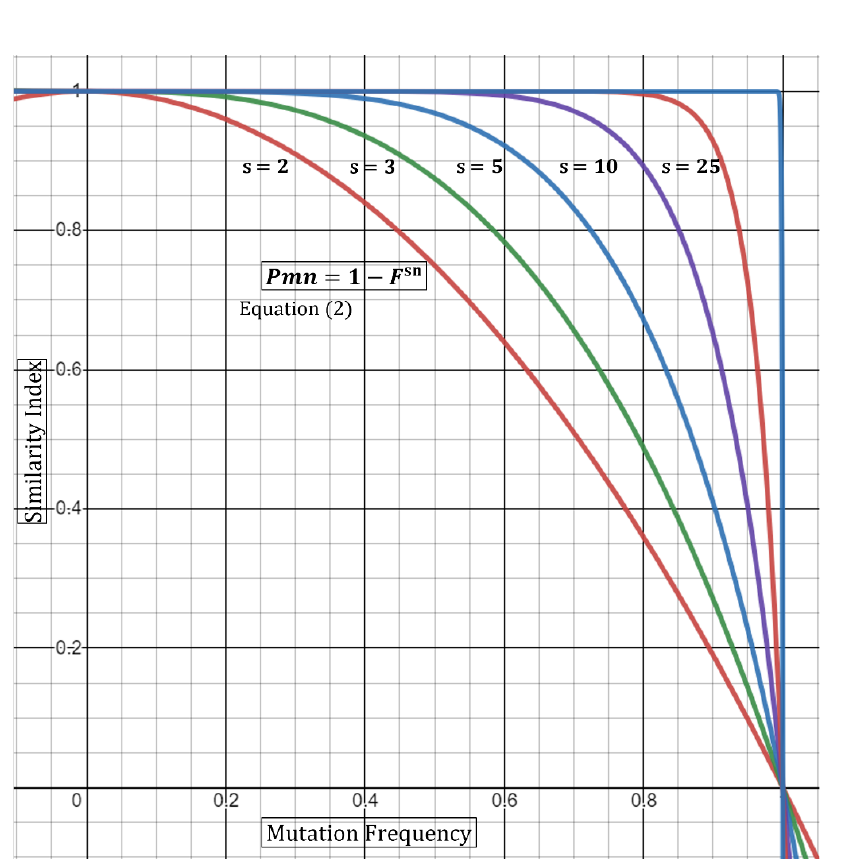
Figure 1. Graphical representation of Equation (2). The graph demonstrates that the probability of a certain mutation ( Pmn ) not to occur randomly is dependent on both the frequency of the mutation ( F ) and the number of samples carrying such mutation ( sn )—Here, sn is varied, and F is kept constant. An increase in sn produces a larger Pm